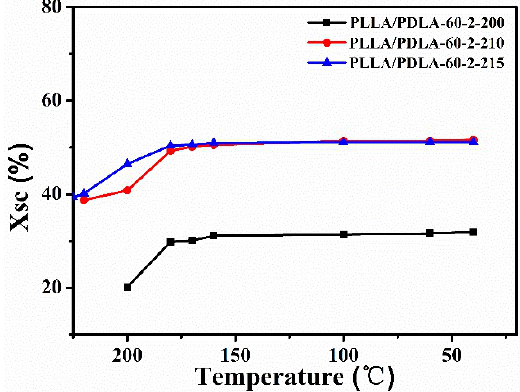
Figure 6. Crystallinity calculated from the WAXS results shown in Figures 3 and 5 for PLLA/PDLA-60-2 fibers after cooled from different temperatures.